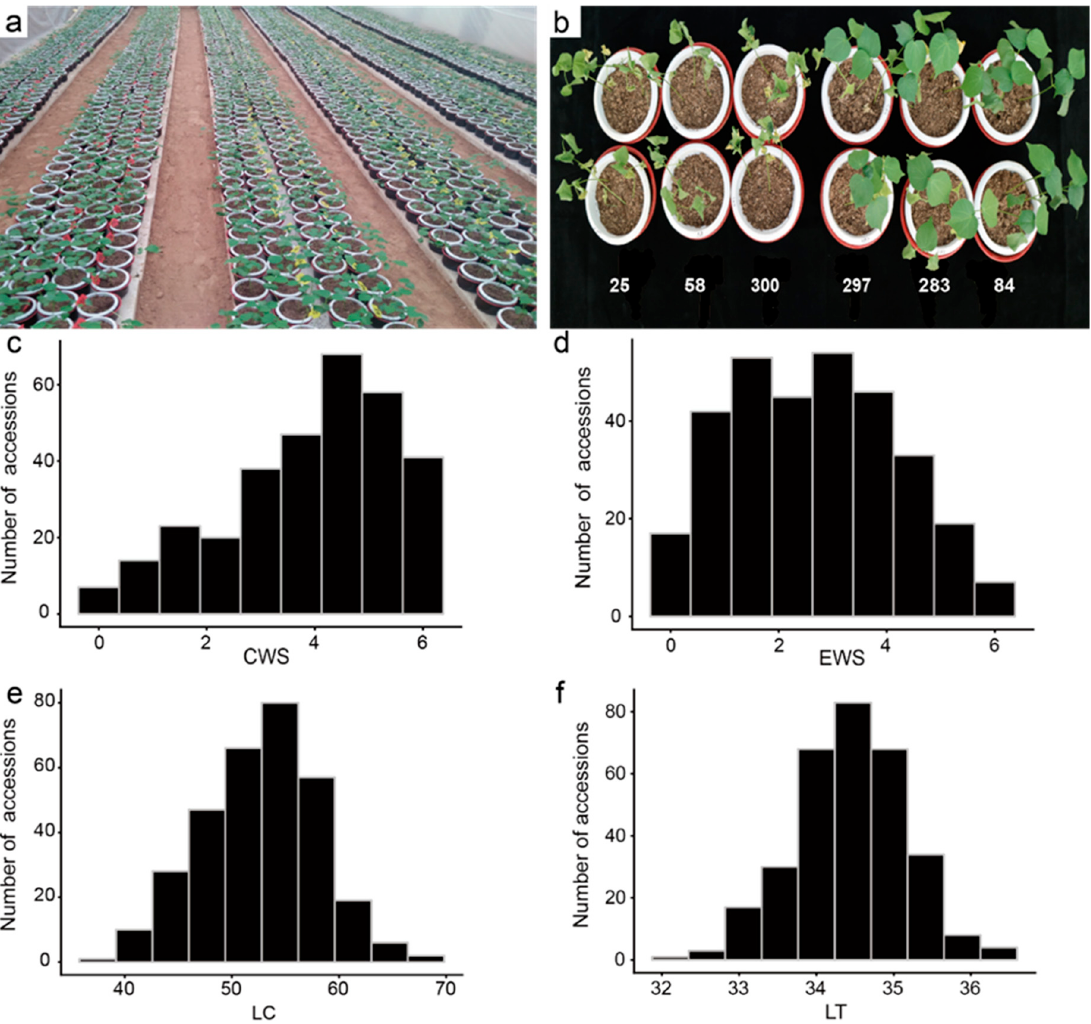
Figure 1. Phenotypes and frequency histograms of the mean values of drought resistance traits of 316 accessions. ( a ) Growth of the cotton population at the seedling stage under normal water conditions; ( b ) Typical phenotypes of the cotton population at the seedling stage after drought stress; ( c – f ) Frequency histograms of the mean values of the CWS, EWS, LC and LT traits of 316 accessions. CWS: cotyledon wilting score; EWS: euphylla wilting score; LC: leaf chlorophyll content; LT: leaf temperature.